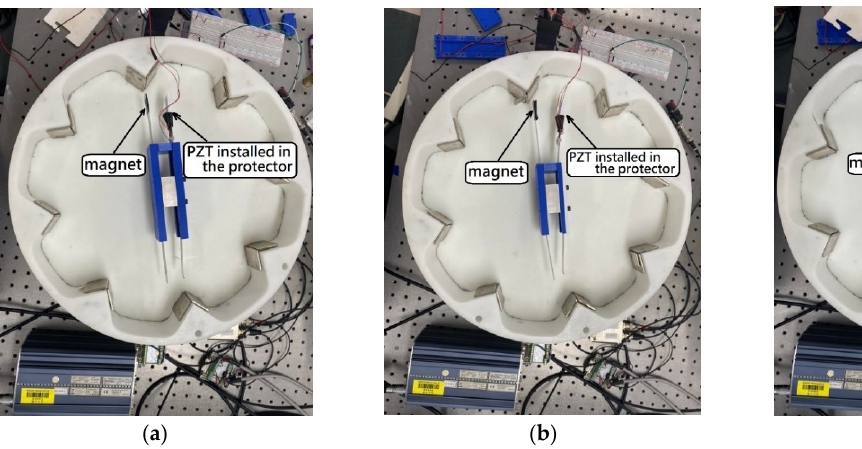
Figure 9. Elastic steel length: ( a ) 5 cm, ( b ) 7.5 cm, ( c ) 10 cm.